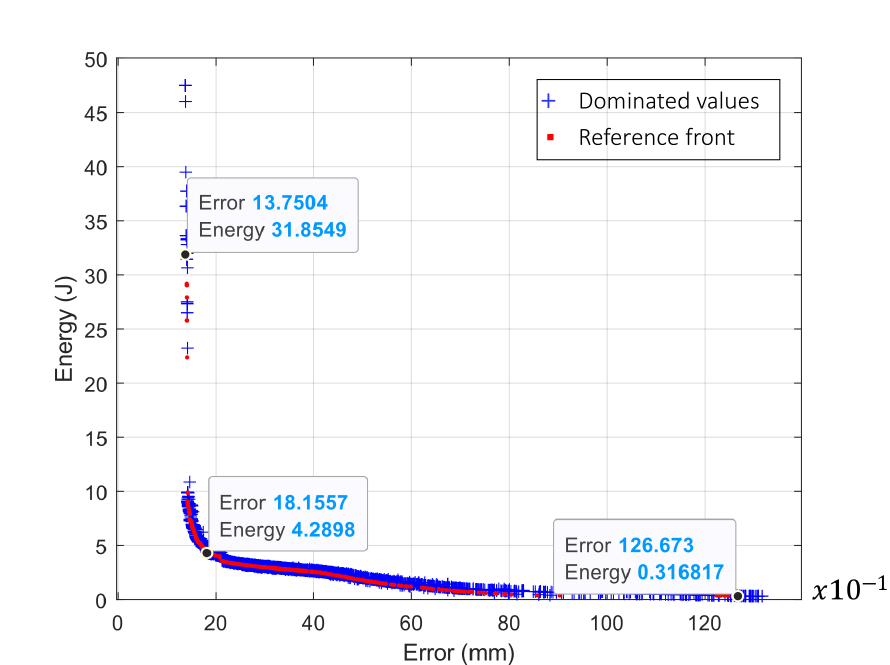
Figure 7. The non-dominated Pareto front versus the dominated error–energy values of both the MOEA/D and NSGA-III executions; labeled points are the configurations in Figure 9.